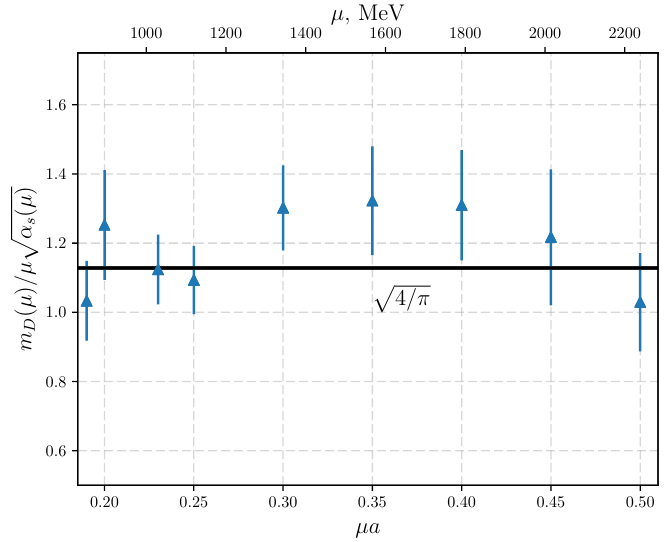
Figure 14 . The expression m (cid:11) s ( (cid:22) )) as a function of chemical potential. The m D ( (cid:22) ) D ( (cid:22) ) = ( (cid:22) and the (cid:11) s ( (cid:22) ) are extracted from (cid:12)t of the (cid:10) 1 ( r; (cid:22) ) data by formula (7.3). At the leading order p approximation the ratio equals to the constant 4 =(cid:25) shown as a black horizontal line. p higher order radiative corrections. In the decon(cid:12)ned phase at (cid:12)nite temperature and zero density one also obtains a large coupling constant (see e.g. [9, 10]). Despite the large coupling constant, it turns out that the one-loop formula (7.1) works quite well. To show this, we compute the ratio m D = ( (cid:22) p (cid:11) s ). At the leading order ap- proximation this ratio is 4 =(cid:25) . In (cid:12)gure 14 we plot this ratio and (cid:12)nd that within the uncertainties of the calculation formula (7.1) works quite well for m D and (cid:11) s extracted p from the color singlet grand